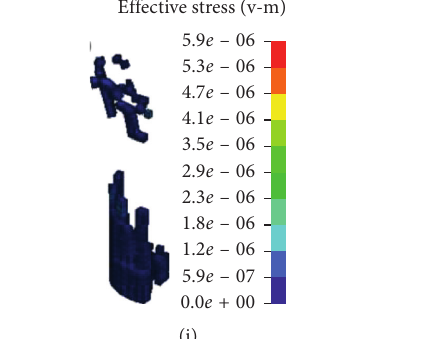
Figure 2: Distribution of the effective stress on the longitudinal section. (a) 0.125m/s. (b) 0.25m/s. (d) 1m/s. (e) 2m/s. (f) 4m/s. (g) 6m/s. (h) 8 m/s. (i)